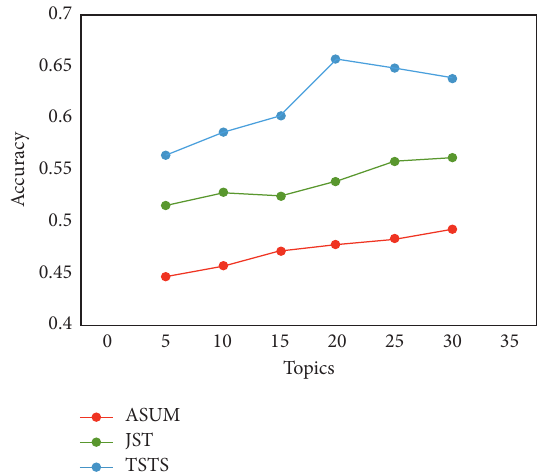
Figure 4: Accuracy of sentiment polarity